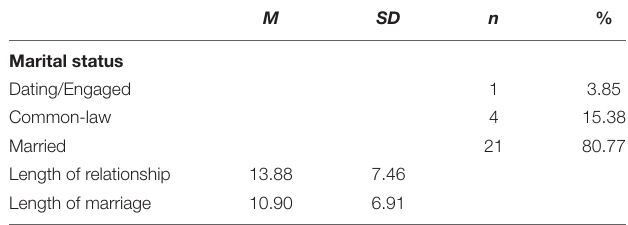
TABLE 2 | Couple characteristics ( N =